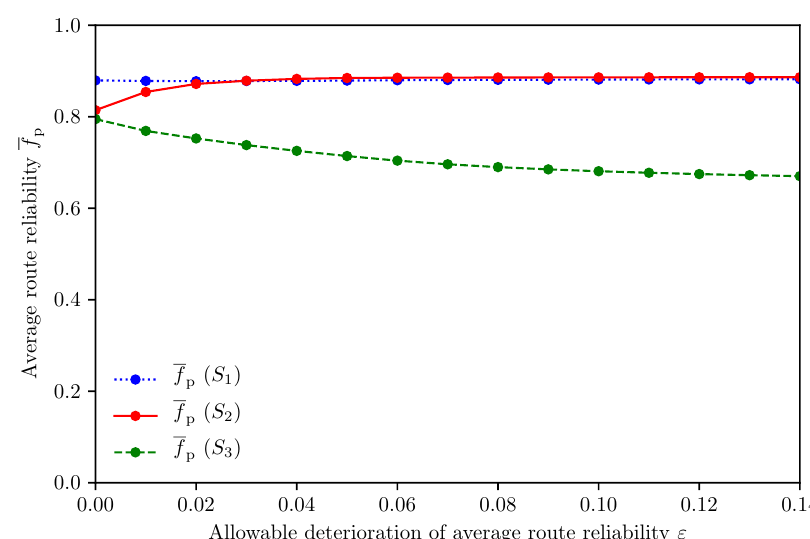
Figure 9. Relationship between ε and f